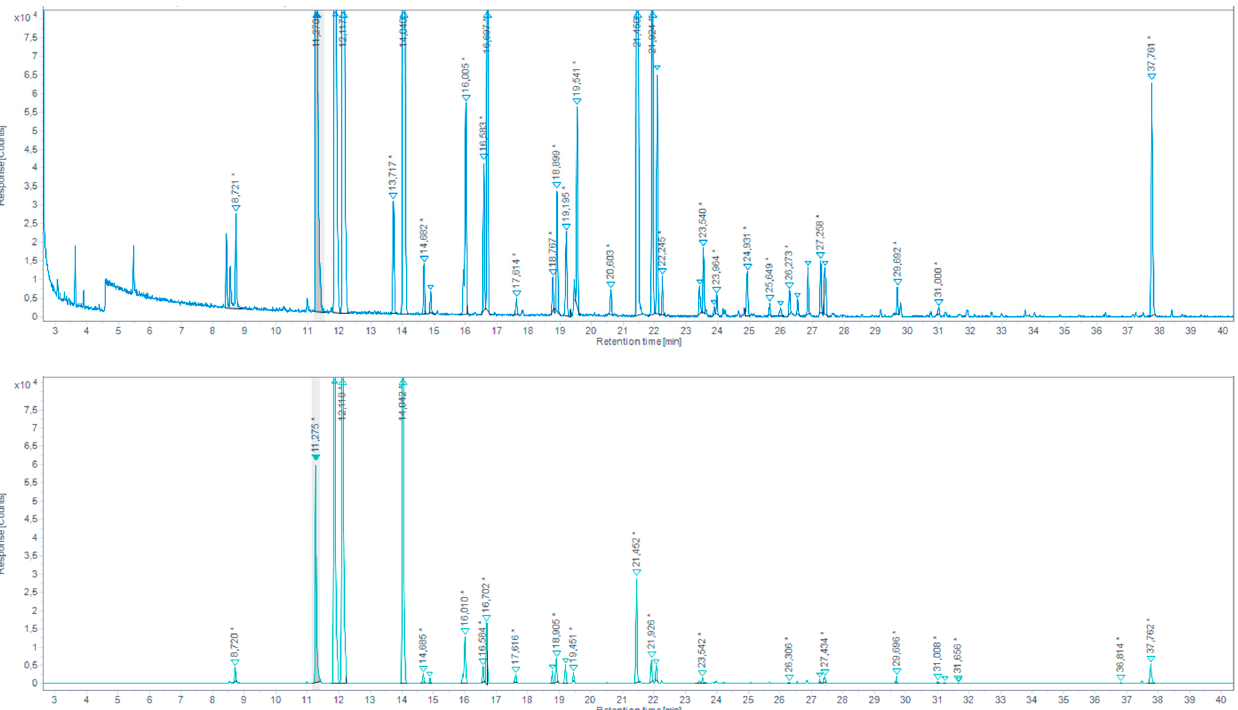
Figure 7. Total ion chromatogram (TIC) for browned chicken meat juices extracted by HS-SDME on PFBHA droplet (up) and the extracted-ion chromatogram (EIC) 180.7–181.7 EI (down). (* indicates that the peak has been manually integrated). Table 5. Identification of carbonyl compounds in browned chicken meat juices extracted by HS- SDME on PFBHA droplet, based on RT, KRI, and fragmentation.